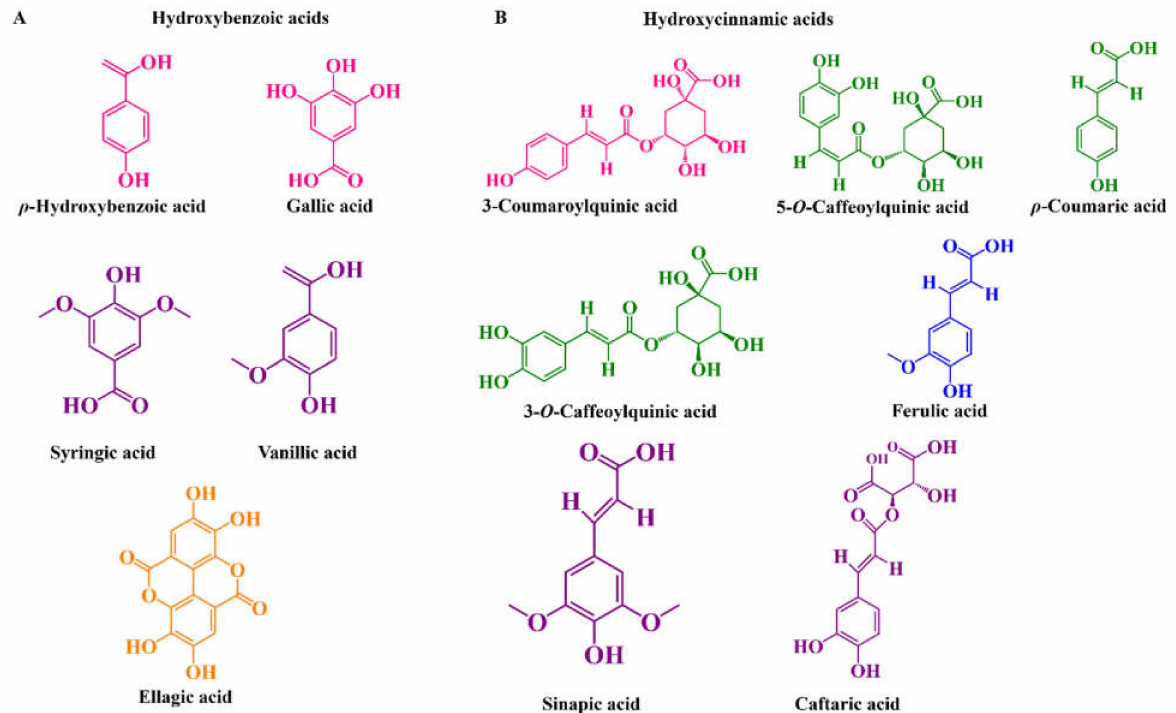
Figure 2. Main hydroxybenzoic ( A ) and hydroxycinnamic ( B ) acids reported in sweet cherries (pink color), and both tart and sweet cherries (green color), highbush blueberries (purple color), rabbiteye blueberries (blue color), and both blueberries (orange color). Vanillic, caftaric and sinapic acids were only detected in highbush blueberries [60,74,91]. (Figure created with ChemDraw Professional 16.0 (CambridgeSoft, Perkin Elmer Inc., Waltham, MA,